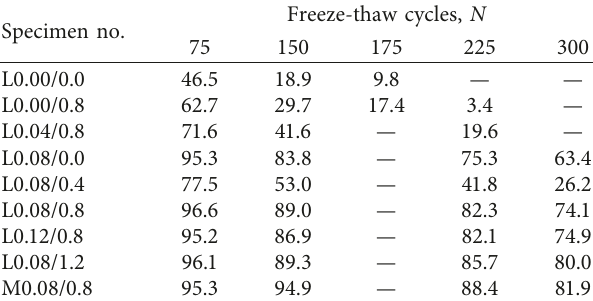
Table 5: Test results of the relative flexural strength of SFRELC. Specimen